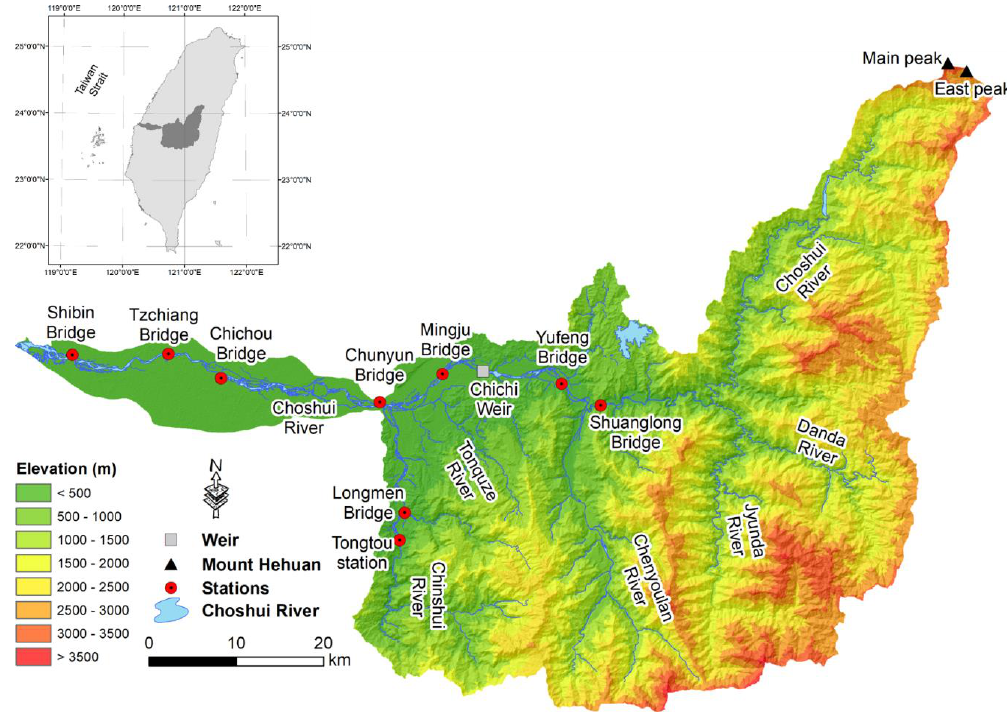
Figure 1. Choshui River catchment of Taiwan.